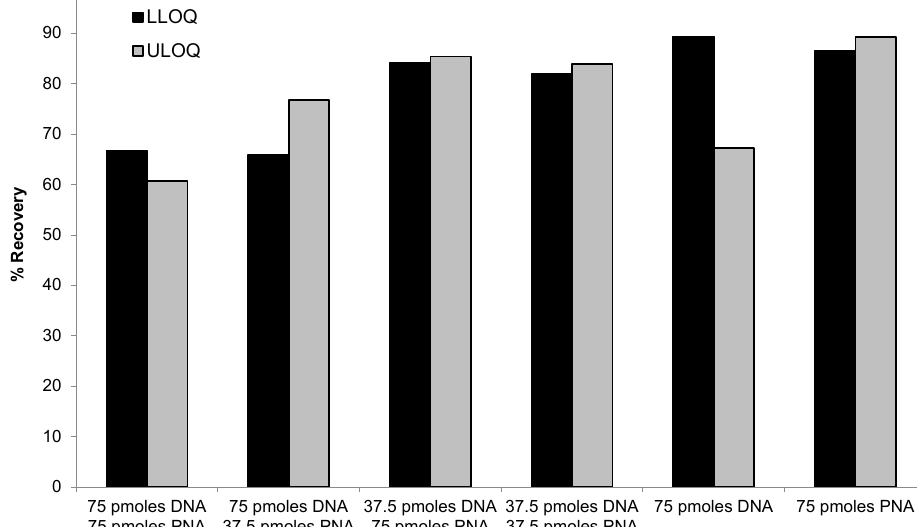
Figure 5. Comparison of different combination of DNA and PNA probes for recovery of siRNA- 01.